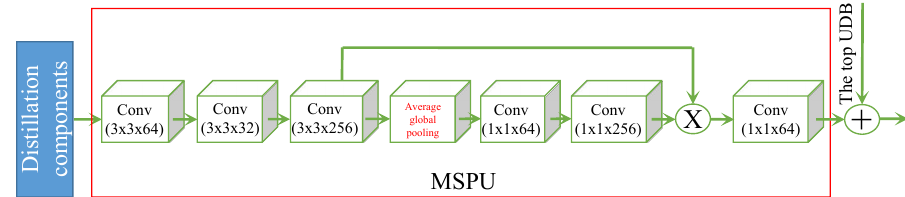
Figure 4. The Multi-scale feature purification unit (MSPU). The distillation components preserved from the different stages are fused to obtain compensation information lost during the information delivery. X denotes the matrix